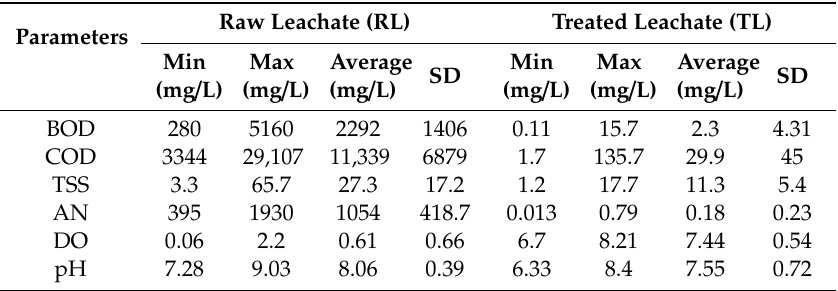
Table 6. Summary of physico-chemical parameters for raw and treated